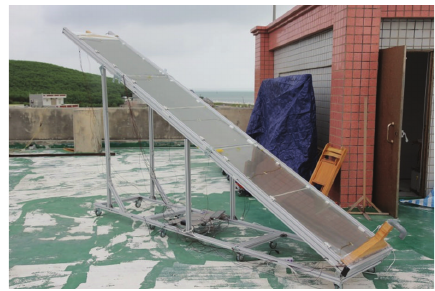
Figure 11: Photo of the solar